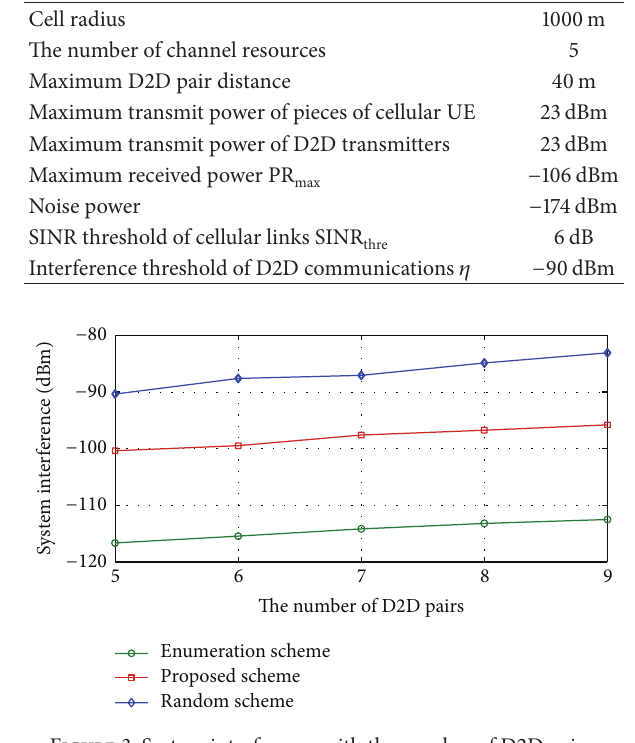
Figure 3: System interference with the number of D2D